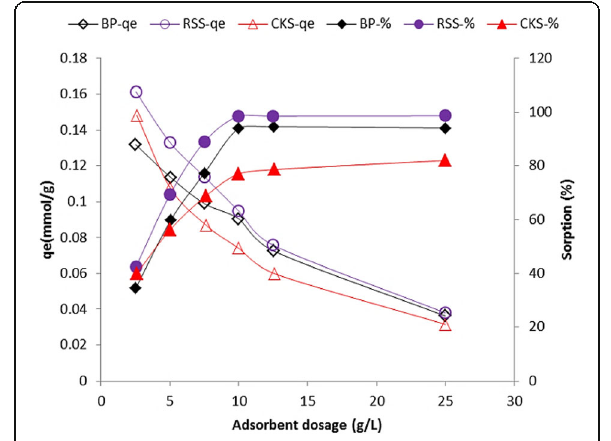
Fig. 4 Effect of adsorbent dosage on adsorption capacity and percentage removal of Cr(VI) ions on the adsorption of Cr(VI) by BP, RSS, and CKS (adsorption conditions: concentration of Cr(VI), 50 ppm; pH 2; contact time, 1 h; temperature, 25 ± 1 °C; λ = 540